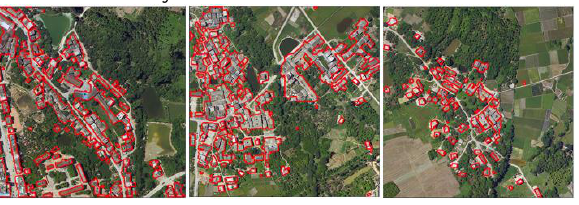
Table 1. Accuracy of TC-SIFT-SPMK methods